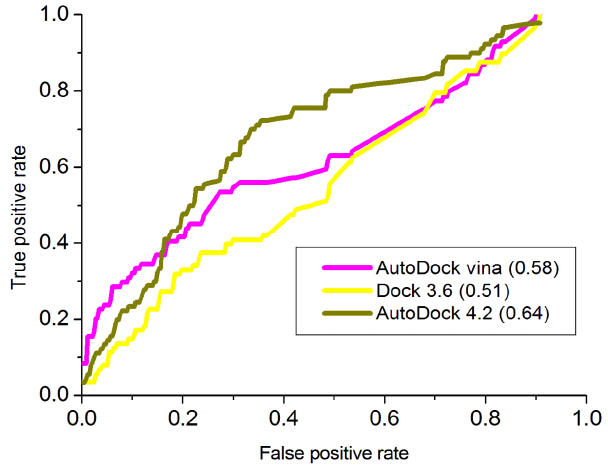
Figure 7. Receiving operating characteristic (ROC)